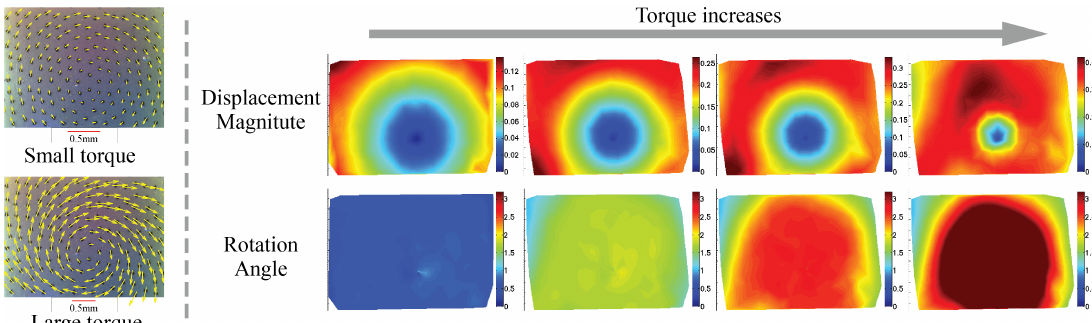
Figure 9. The change of the marker displacement field and rotational angle with the increase of in-plane torque. The contact surface is flat. When the torque grows large, partial rotational slip or full slip occurs, starting from the peripheral area. The partial rotational slip results in the inhomogeneous distribution of the markers’ rotational angle. The experiment is conducted with a fingertip GelSight sensor [30] (Got copyright permission from IEEE) whose surface is flat, and the object in contact is a flat